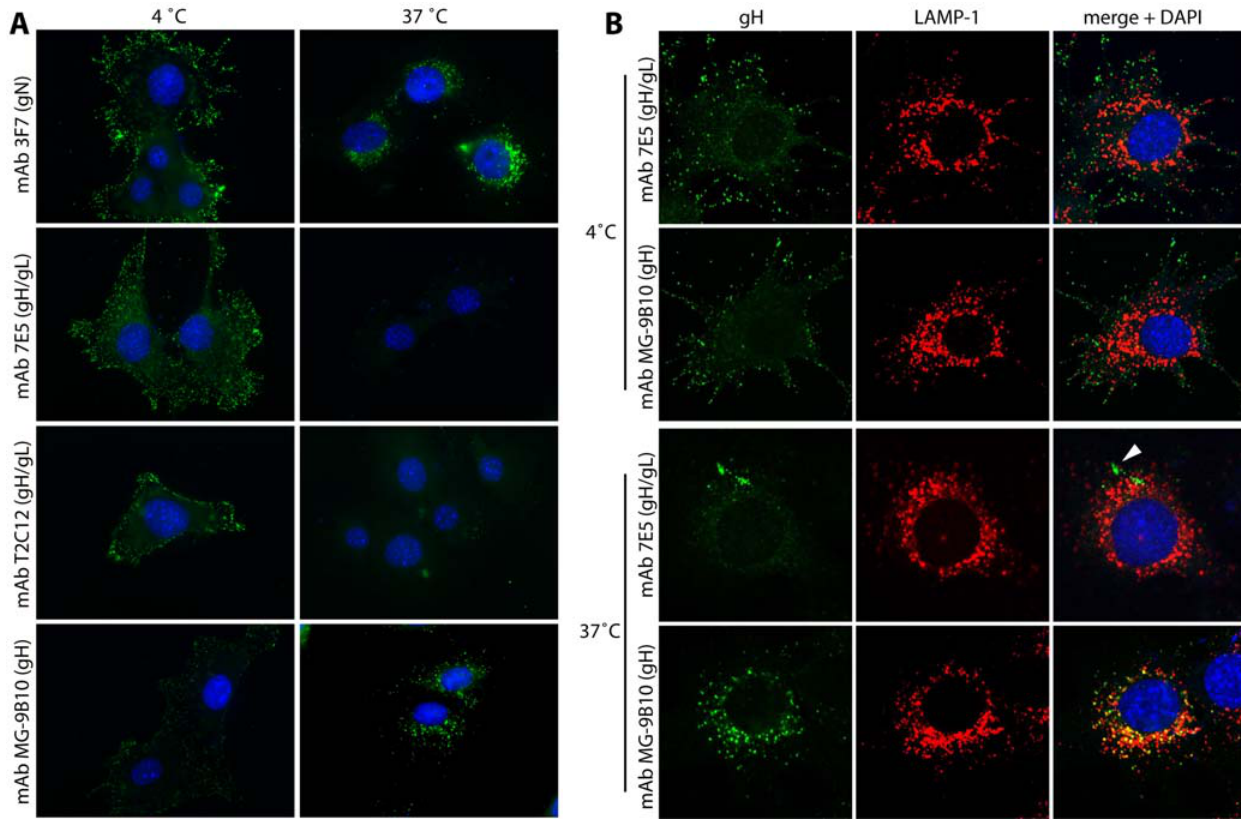
Figure 1. Glycoprotein H changes its antigenicity after endocytosis. A. NMuMG cells were exposed to MuHV-4 virions (3 p.f.u./cell, 2 h, 4 u C), washed 6 3 with PBS and either fixed immediately (4 u C) or after a further 2 h incubation at 37 u C (37 u C). The cells were then stained for gH (MG-9B10), gH/gL (T2C12, 7E5) or gN (3F7) as an invariant control. Glycoprotein staining is green; nuclei are counterstained with DAPI (blue). The data are representative of 5 experiments, and similar results were obtained with 3 other gH-specific/gH/gL-specific mAb pairs. Single cells are shown for optimal resolution. In this as in subsequent figures, each individual cell is fully representative of at least 75% of the total examined (n . 100). B. Cells were infected as in A , then stained for LAMP-1 (red) plus either gH (mAb MG-9B10) or gH/gL (mAb 7E5) (green). Co-localization is yellow. The arrow indicates residual gH/gL staining that does not colocalize with LAMP-1.